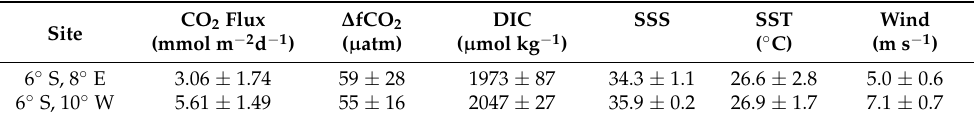
Table 4. Mean and standard deviation of the carbon parameters, salinity and temperature at 6 ◦ S, 8 ◦ E and 6 ◦ S, 10 ◦ W from March to August 2017 from observations at the PIRATA moorings. The winds are from the Cross-Calibrated Multiplatform